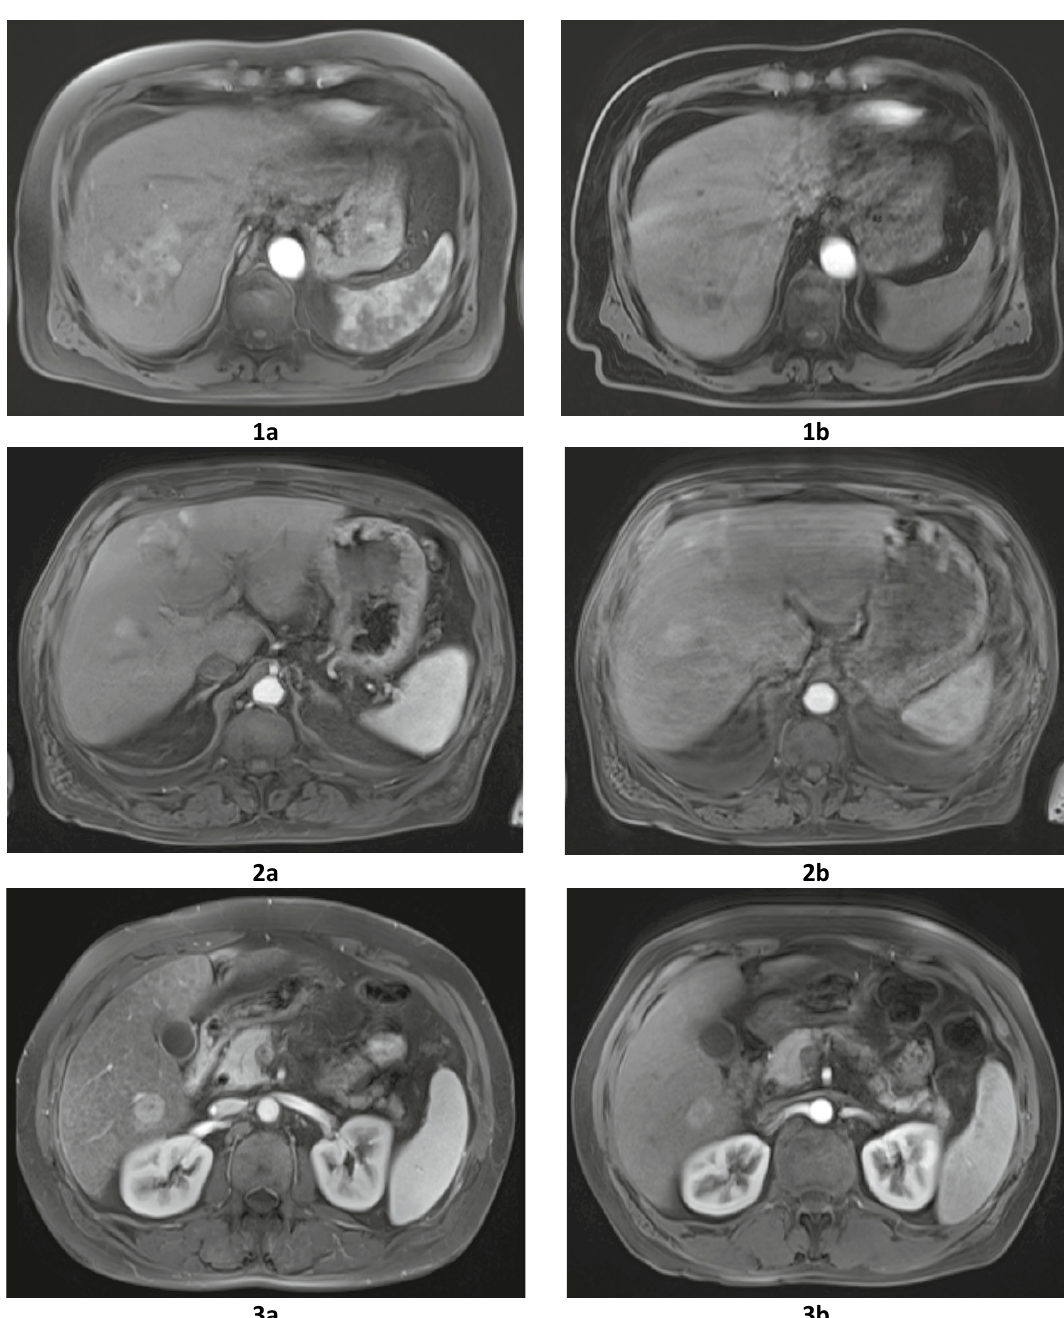
Figure 2. Qualitative analysis of overall image quality, the presence of artifacts as well as the conspicuity of HCC lesions during the arterial phase after administration of gadoteric acid and gadoxetic acid in three different patients. Figures( 1a–3a ) demonstrates higher image quality, lower artifacts as well as the higher conspicuity of HCC lesions during the arterial phase after administration of the extracellular contrast agent gadoteric acid than with the hepatocyte-specific contrast agent gadoxetic acid ( 1b–3b